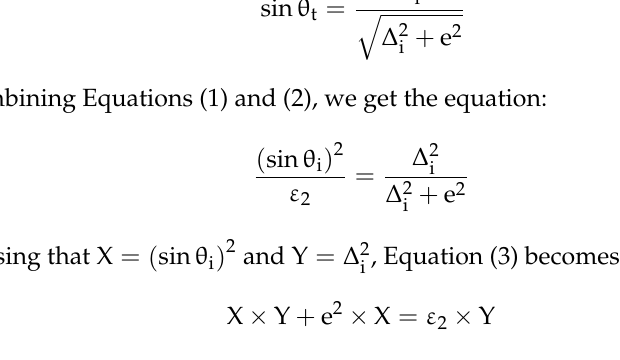
Figure 3. Schemas for geometrical relation between e, Δ i , and θ t : ( a ) Effect of the interference on the thermogram in transmission approach ( α = 15°) [35]; ( b ) Simplified schema of refracted waves around a steel bar.